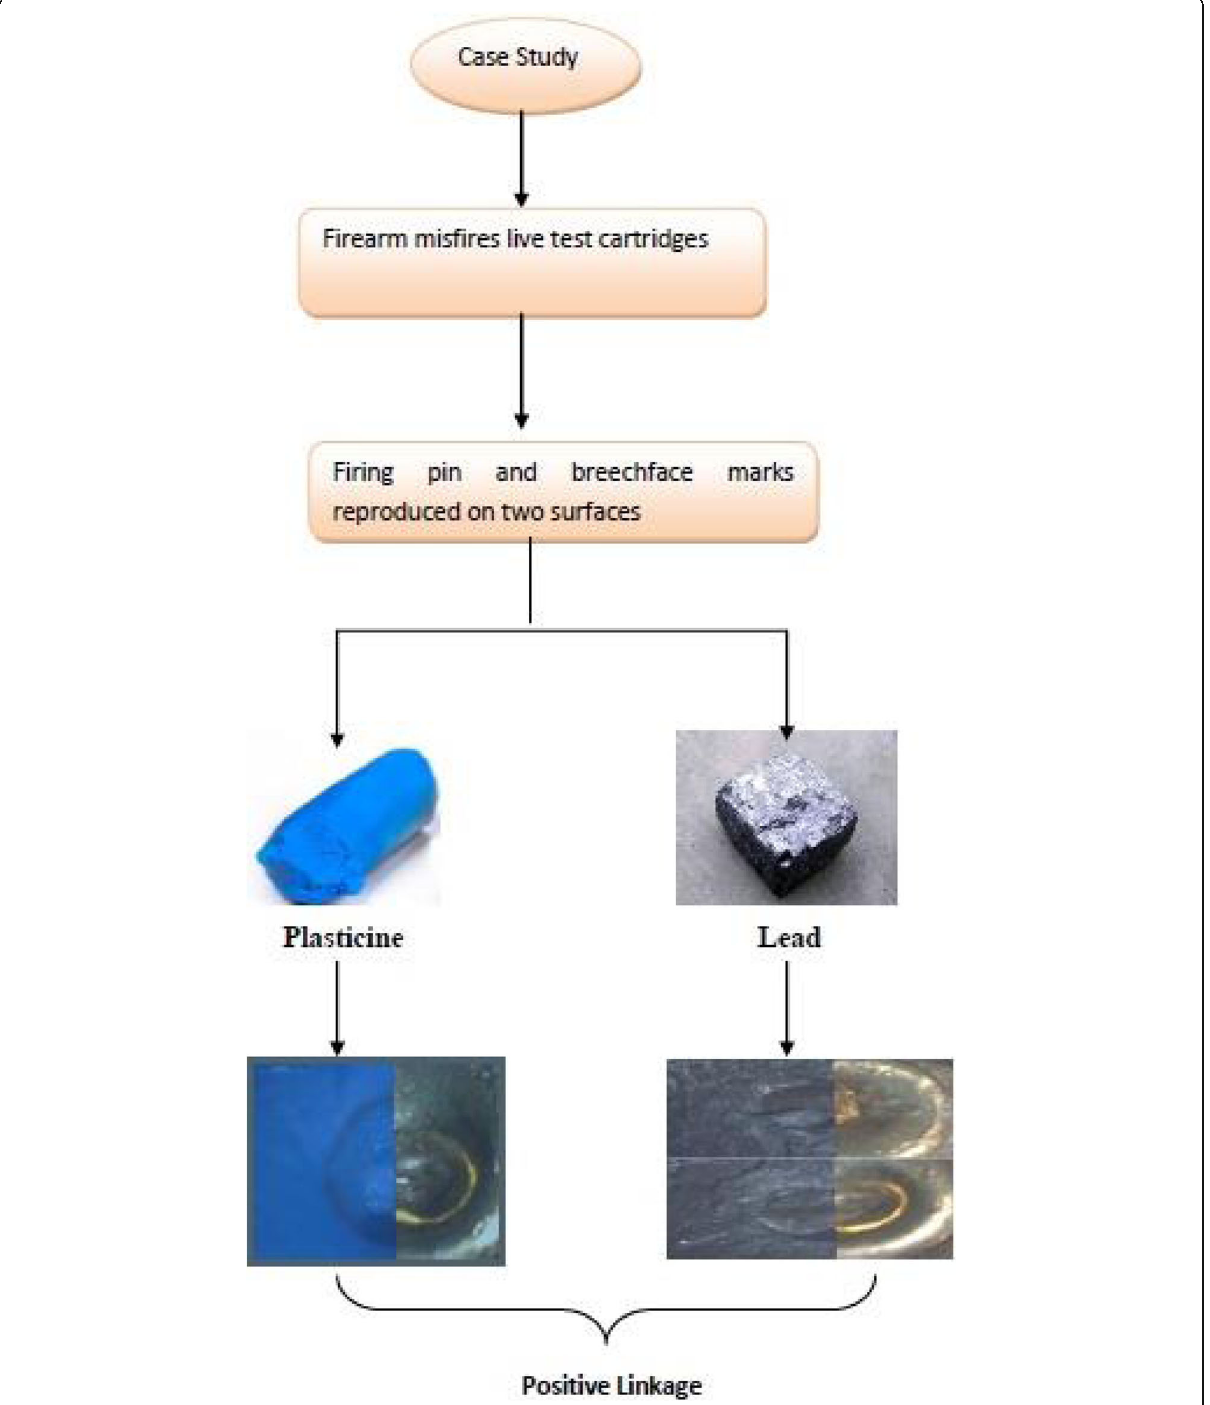
Fig. 3 Showing flow chart of methodology